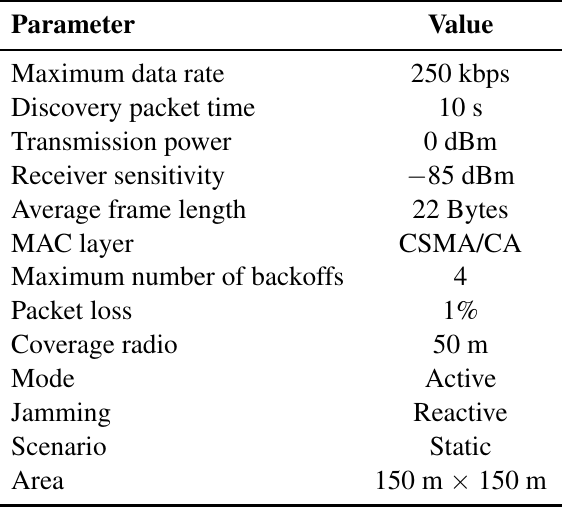
Table 11. Parameters for the tested